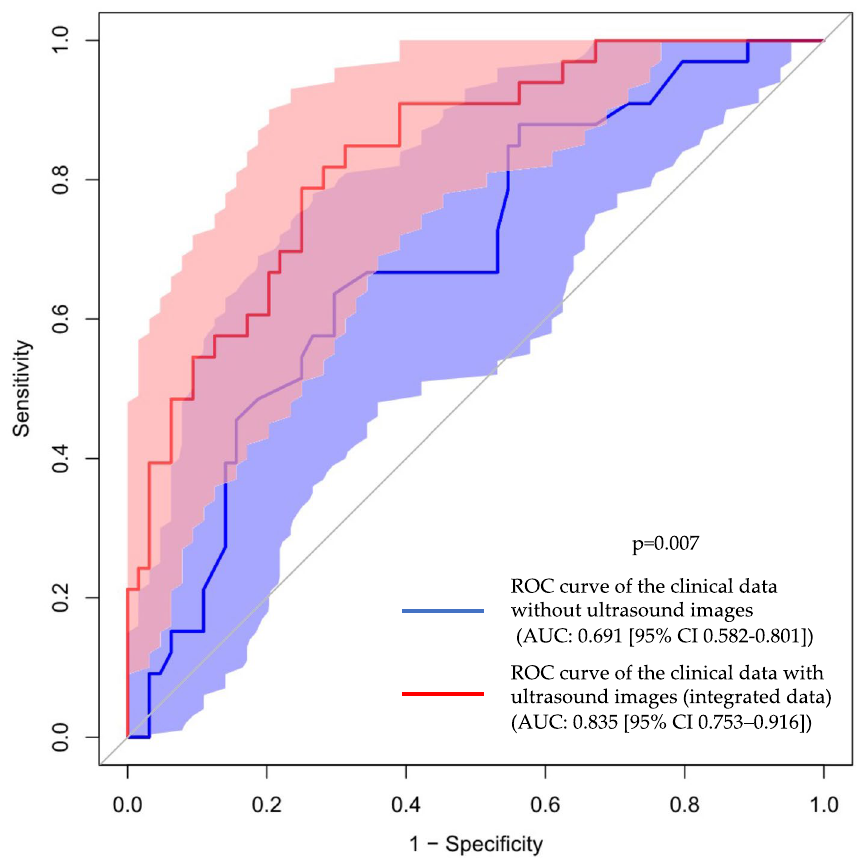
Figure 2. ROC curves of high-grade cancer classification (n = 691: systematic biopsy and MRI-targeted biopsy cases). Blue line: ROC curve of the clinical data without ultrasound images. Red line: ROC curve of clinical data with ultrasound images (integrated data). Light blue area: 95% CI for the ROC curve of the clinical data without ultrasound images. Light red area: 95% CI for ROC curve of clinical data with ultrasound images (integrated data). ROC receiver operating characteristic, AUC area under the curve, CI confidence